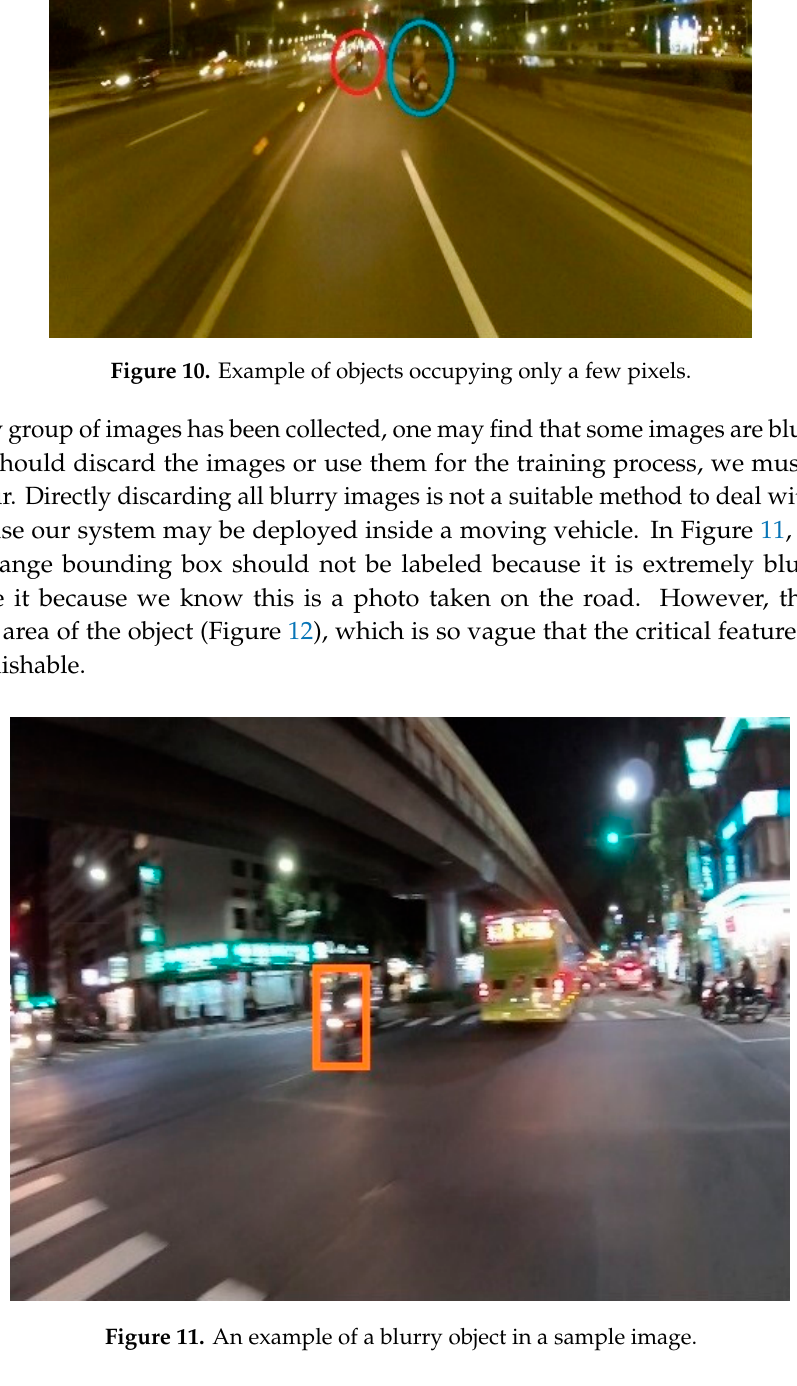
Figure 12. The blurry object from Figure 11. 3.2.2. Hyperparameter Adjustments and Optimized Training Process Many adjustments were made and various hyperparameters were carefully selected during the development and fine-tuning of the model. A suitable training process is the key to achieving a superior nighttime vehicle detection performance. After several experiments, we selected the initial learning rate to be 0.001, which decayed to 0.0001 after 200,000 iterations for ResNet101 [2] and 50,000 iterations for VGG16 [1]. The double learning rate was used for updating biases throughout the entire training process. This practice follows recent convention instead of the traditional standard training process. Apart from the parameters that were initialized by pretrained models, other parameters were initialized by the truncated normal distribution. The testing speed of convergence was acceptable and reasonable in our nighttime data set of real traffic conditions. For the hyperparameters of the Faster R-CNN [5], we selected the usual setting for ROIs. The overlap threshold for an ROI was set to be 0.5 for considering the foreground. The overlap threshold for an ROI and the ground-truth box to be used as a bounding regression box was set to as 0.5. With regard to the RPN, we selected 0.7 as the intersection over union (IOU) threshold to indicate a positive example, and a threshold of 0.3 to indicate a negative example. The threshold of non-max suppression used on RPN proposals [5] was also set as 0.7. A significant number of top-scoring boxes were maintained before and after non-max suppression was applied to RPN proposals [5]. With reference